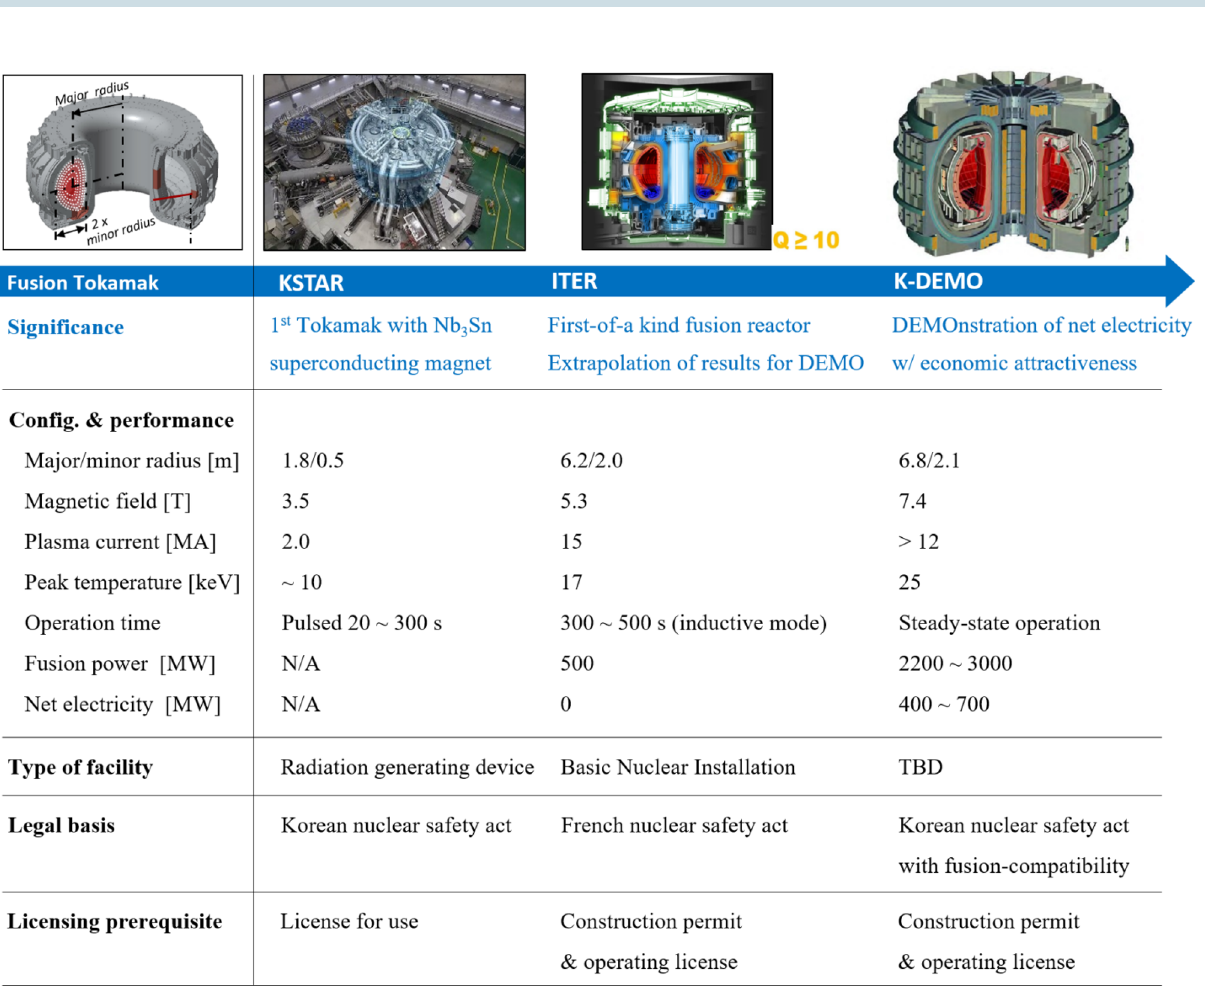
Figure 1. Key details of the representative fusion facilities and licensing requirements under local regulatory frameworks.